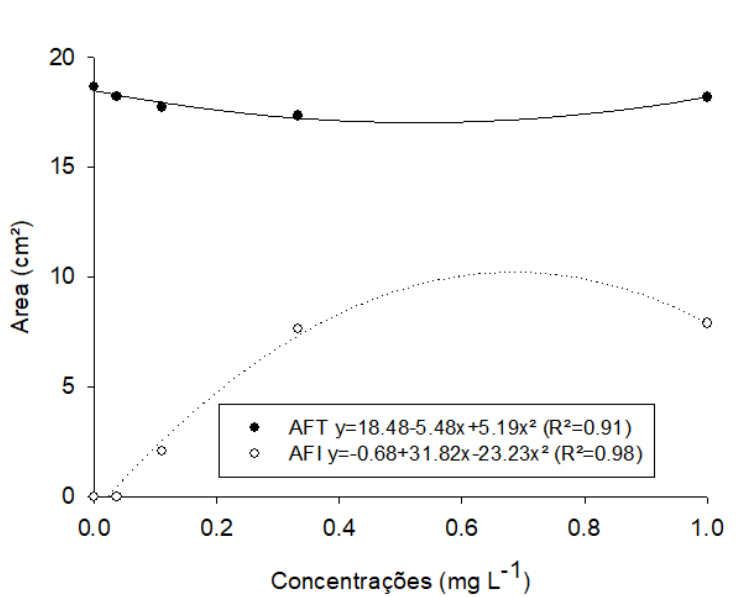
Figure 3. Total leaf area (TLA) and injured leaf area (ILA) of P. stratiotes at 45 days after clomazone